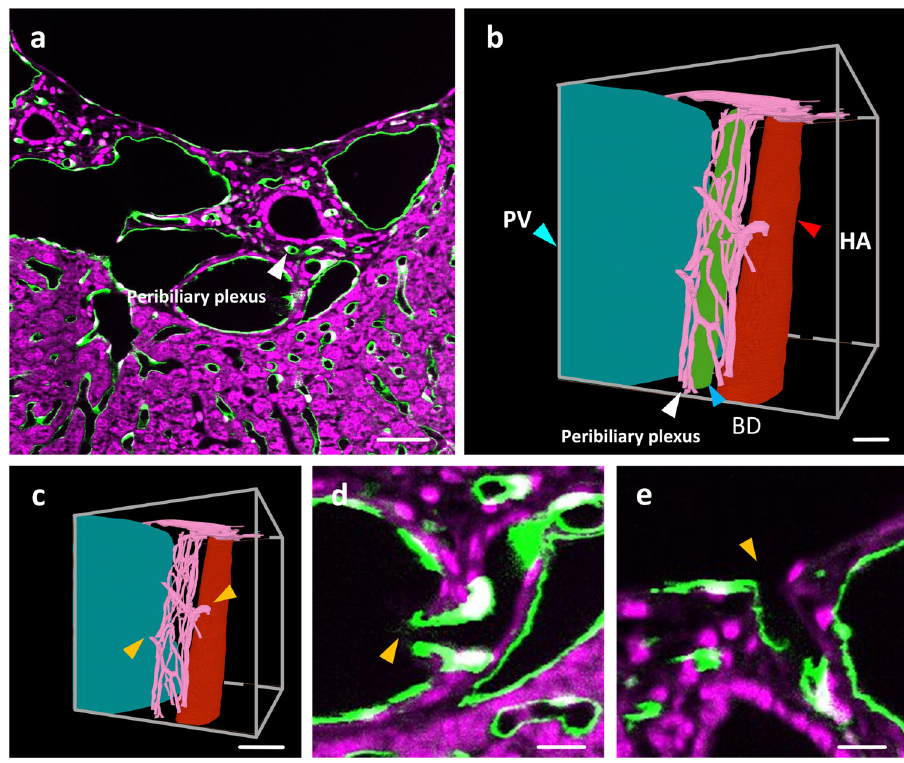
Fig. 5 The reconstruction of the peribiliary plexus. a The vessel distribution of the portal triads. Bile ducts and peribiliary are pointed with the white arrow. b Reconstruction of vessels in a selected local block. Portal vein, hepatic artery, bile ducts, and peribiliary plexus are respectively marked in blue, red, green, and pink. The cyan arrow indicates portal vein. The red arrow indicates hepatic artery. The white arrow indicates peribiliary plexus. The blue arrow indicates bile ducts. c The intersection of the peribiliary vascular plexus with the hepatic artery and portal vein is marked using yellow arrows. d The merged channel image at the intersection of hepatic artery and peribiliary vascular plexus indicated with the upper right arrow in ( c ). The intersection is marked with the yellow arrows. e The local area of merged channel images at the intersection between portal vein and peribiliary vascular plexus indicated with the lower left arrow in ( c ). The intersection is marked with yellow arrow. PV portal vein, HA hepatic vein, BD bile duct. Scale bar, 25 μ m ( a, b ), 50 μ m ( c ), 10 μ m ( d , e